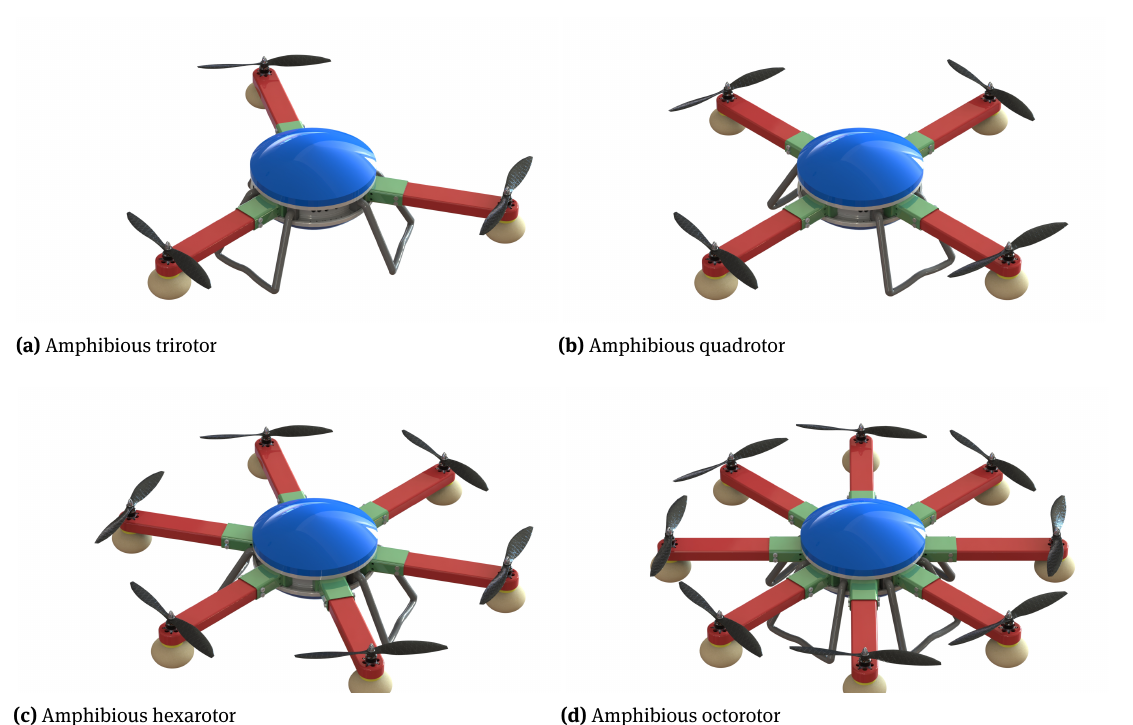
Figure 13: Multirotor configurations with amphibious characteristics and inflatable elements.